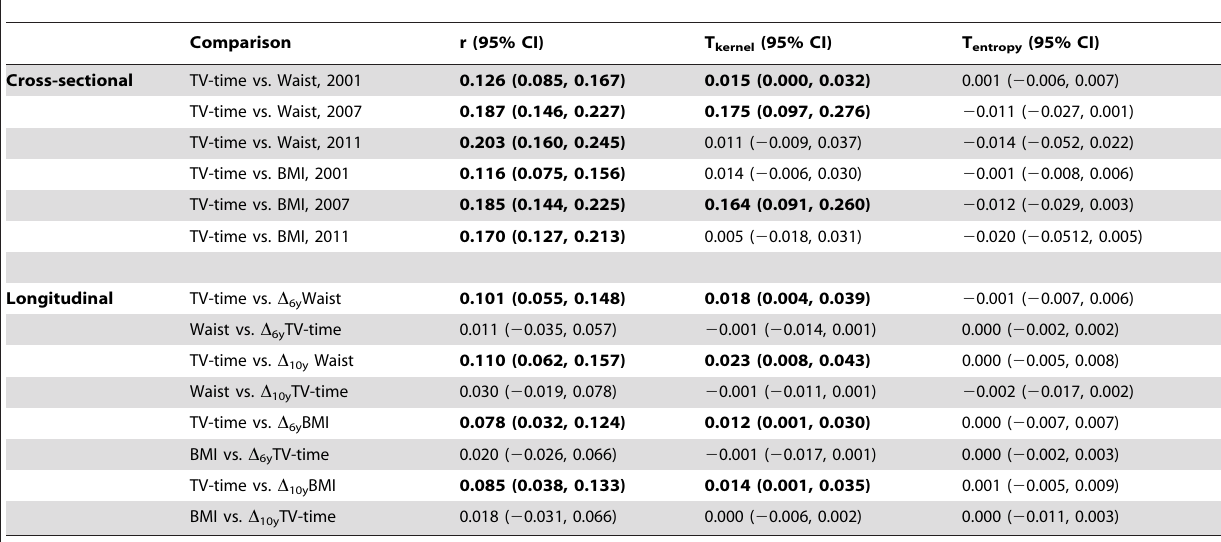
Table 4. Correlations and Pairwise Causality Statistics between the Study